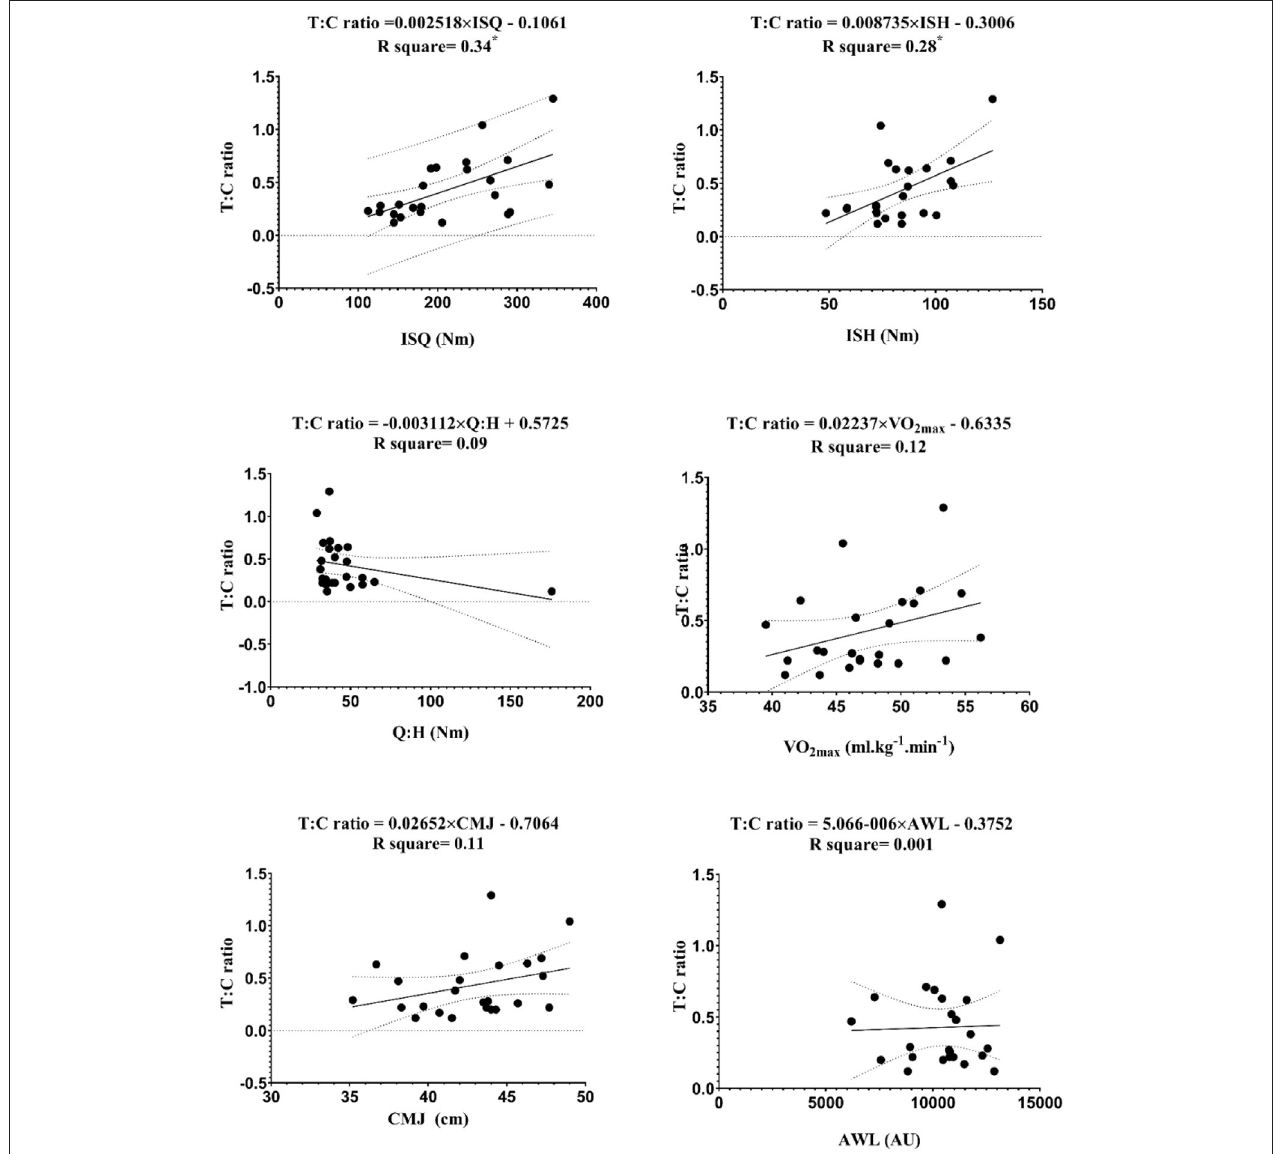
FIGURE 7 | Regression analysis to explain fitness levels and AWL (the average of the three stages) with GH, growth hormone; ISH, isometric muscular strength of the hamstring muscles; ISQ, isometric muscular strength of the quadriceps muscles; H:Q, the strength of isometric quadriceps to hamstring ratio; VO 2max , maximal oxygen uptake; CMJ, countermovement jump; AWL, accumulated workload training; Nm, Newton meter; AU, arbitrary unit. * Significant differences p ≤